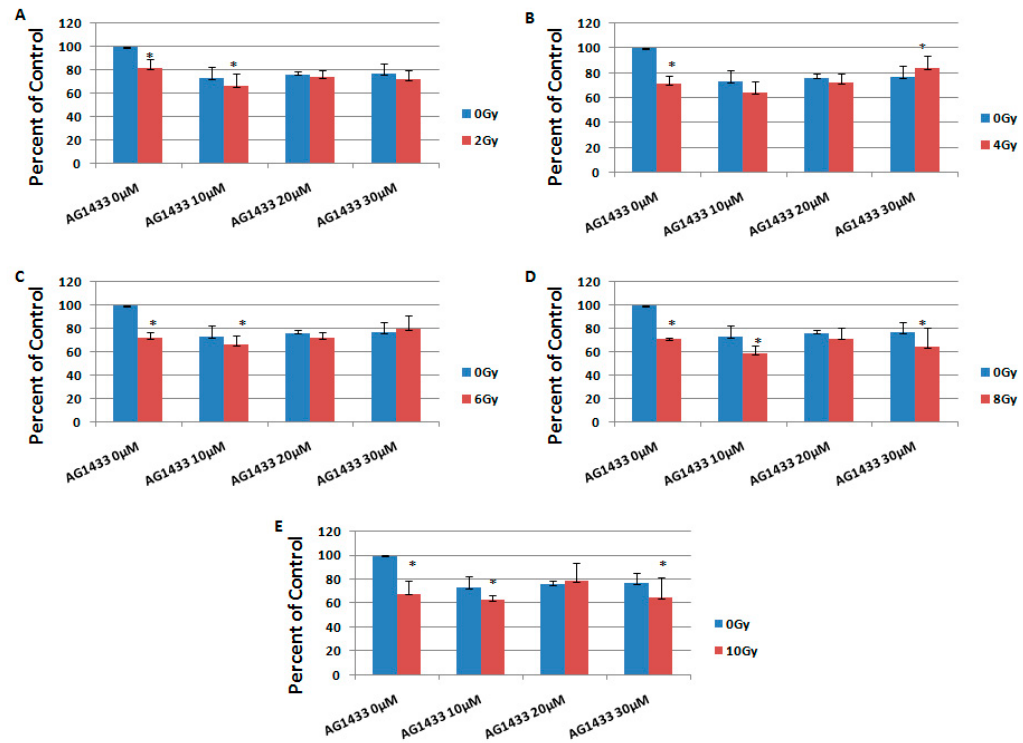
Figure 5. The e ff ect of PDGFR inhibition on ionizing radiation response in 15 HGG cells, 3 days Figure 5. The effect of PDGFR inhibition on ionizing radiation response in 15 HGG cells, 3 days after the treatment. The cells were seeded in 96-well culture plates (5000 cells/well) then irradiated with 2 Gy ( A) ; 4 Gy ( B ); 6 Gy ( C ); 8 Gy ( D ); 10 Gy ( E ) and treated with 10, 20, or 30 µM AG556. The cells